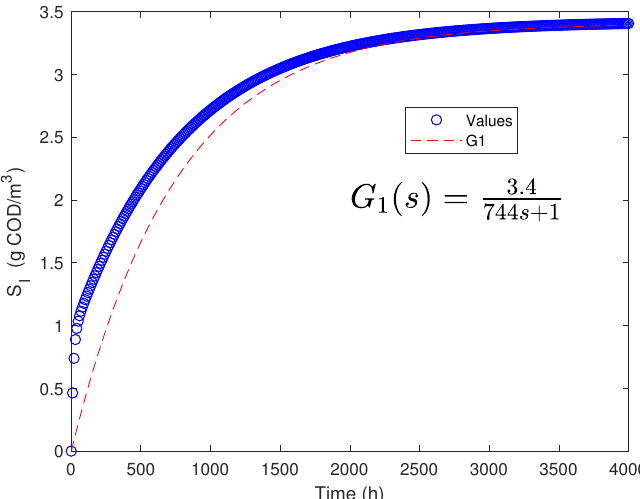
Figure 2. Simulated response of the industrial scale RAS to a step increase in an inert soluble component production rate by 1 gCOD/(m 3 h). First order model presented for comparison ·